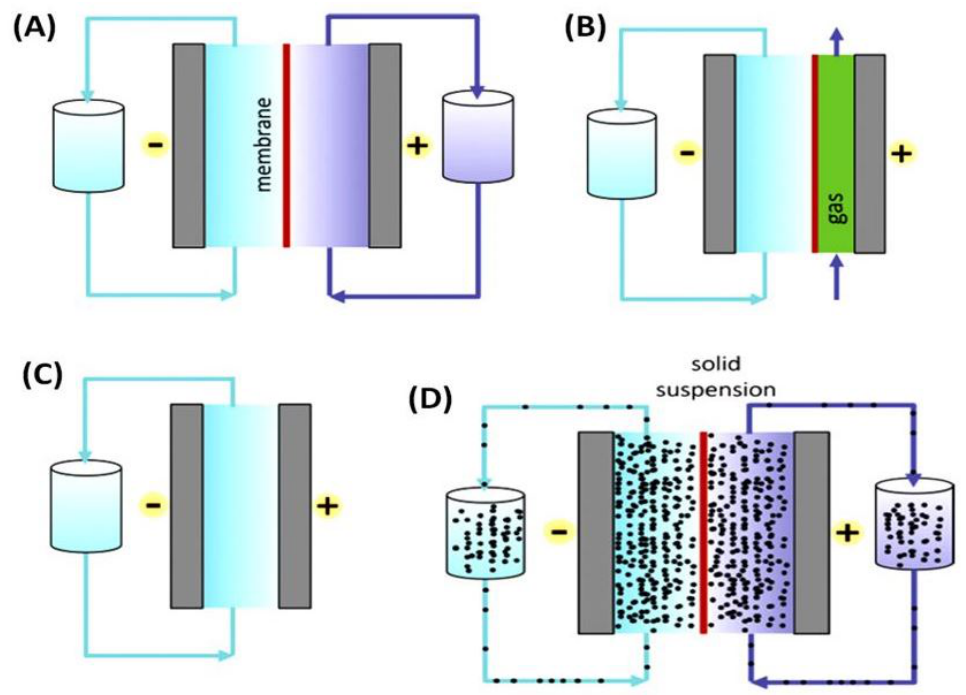
Figure 2. Conceptual designs of four different RFBs: ( A ) conventional redox flow battery with two compartments of dissolved redox active species, ( B ) hybrid RFB with gas supply at one electrode, ( C ) membraneless RFB configuration, and ( D ) RFB with solid particle suspension as flowing